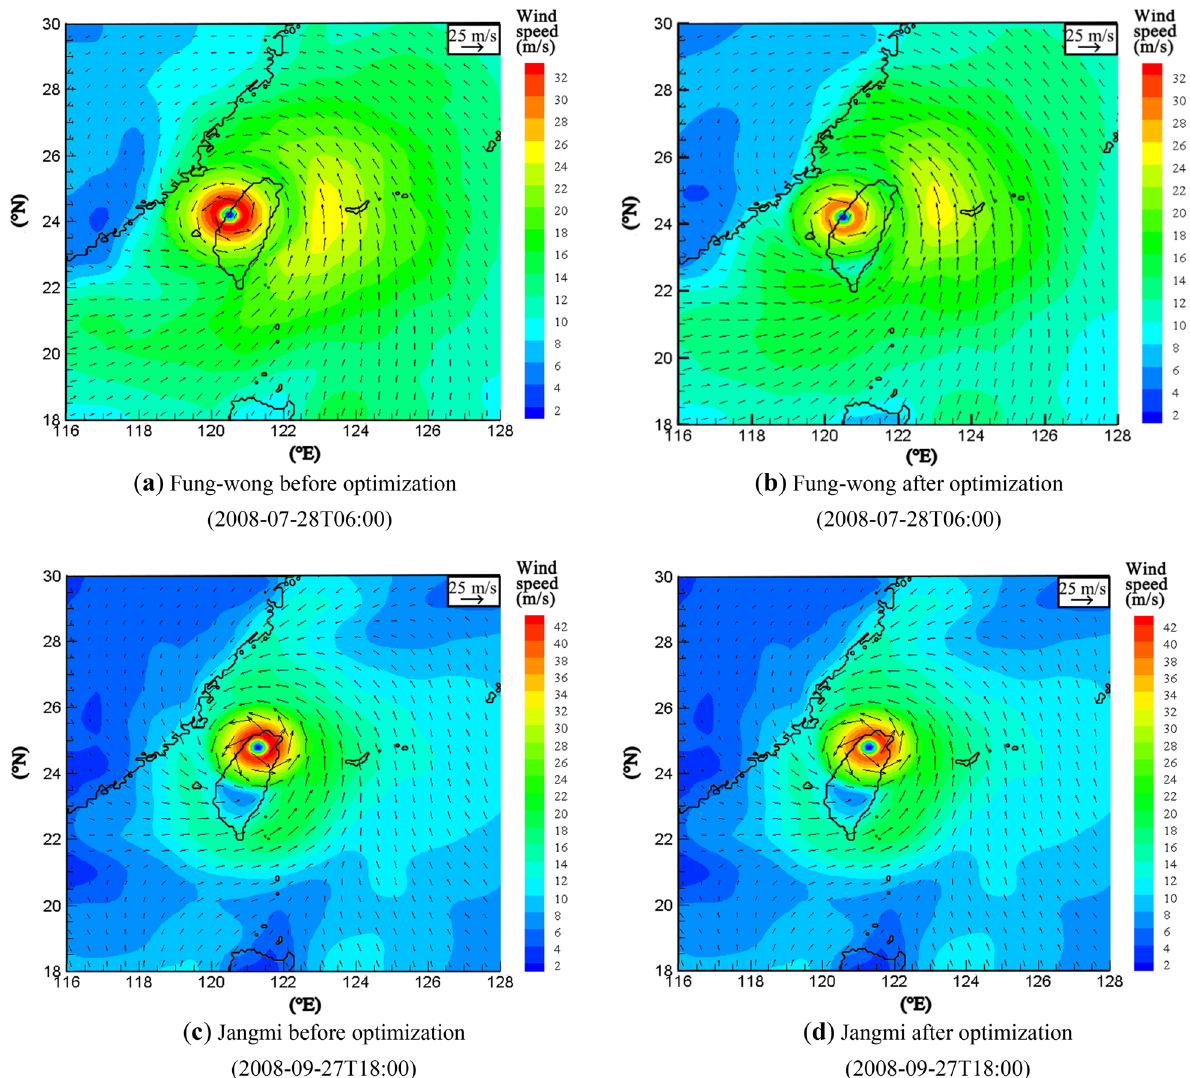
Fig. 8 The distribution of wind speed and vector before and after optimization when typhoon Fung-wong left Taiwan Island (2008-07-28T06:00) and when Jangmi landed on Taiwan Island